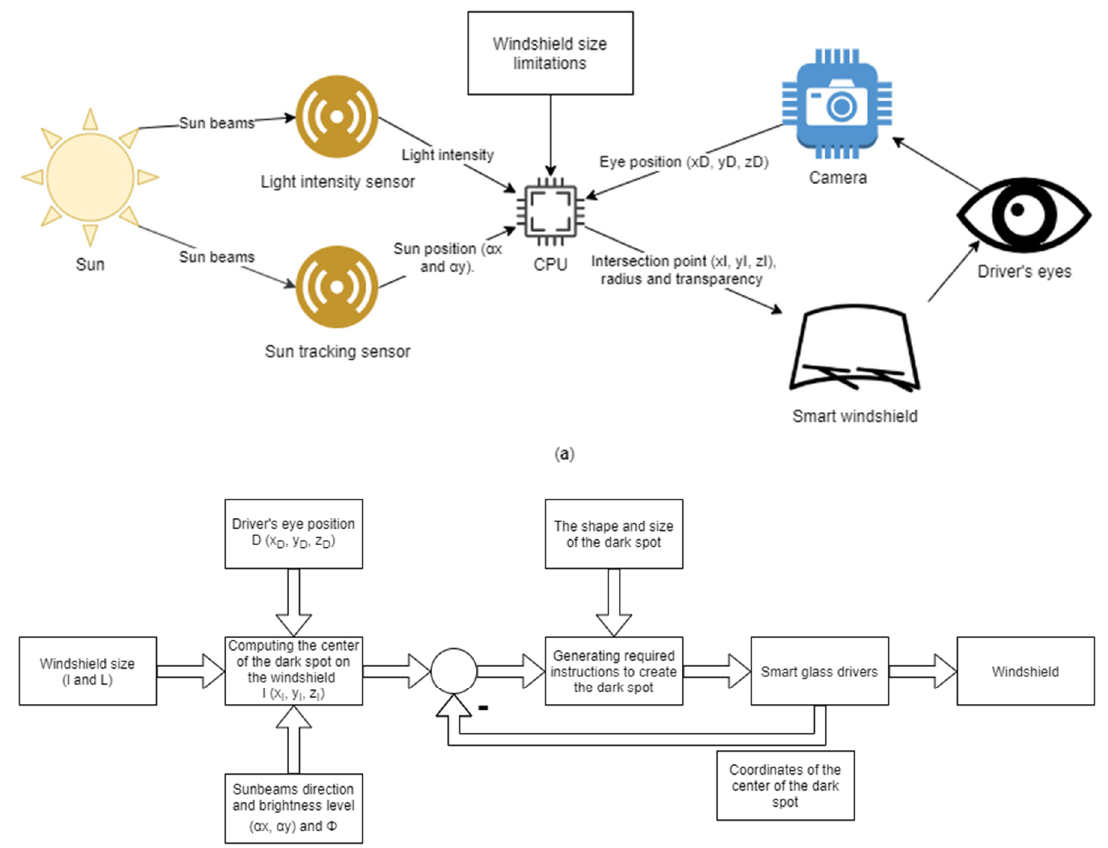
Figure 1. ( a ) A graphical overview of the digital sunshade system. ( b ) Block diagram of the digital sunshade system.